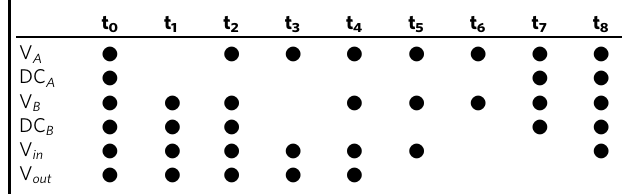
Table 3 Timing sequence for membrane valve-based mixer.